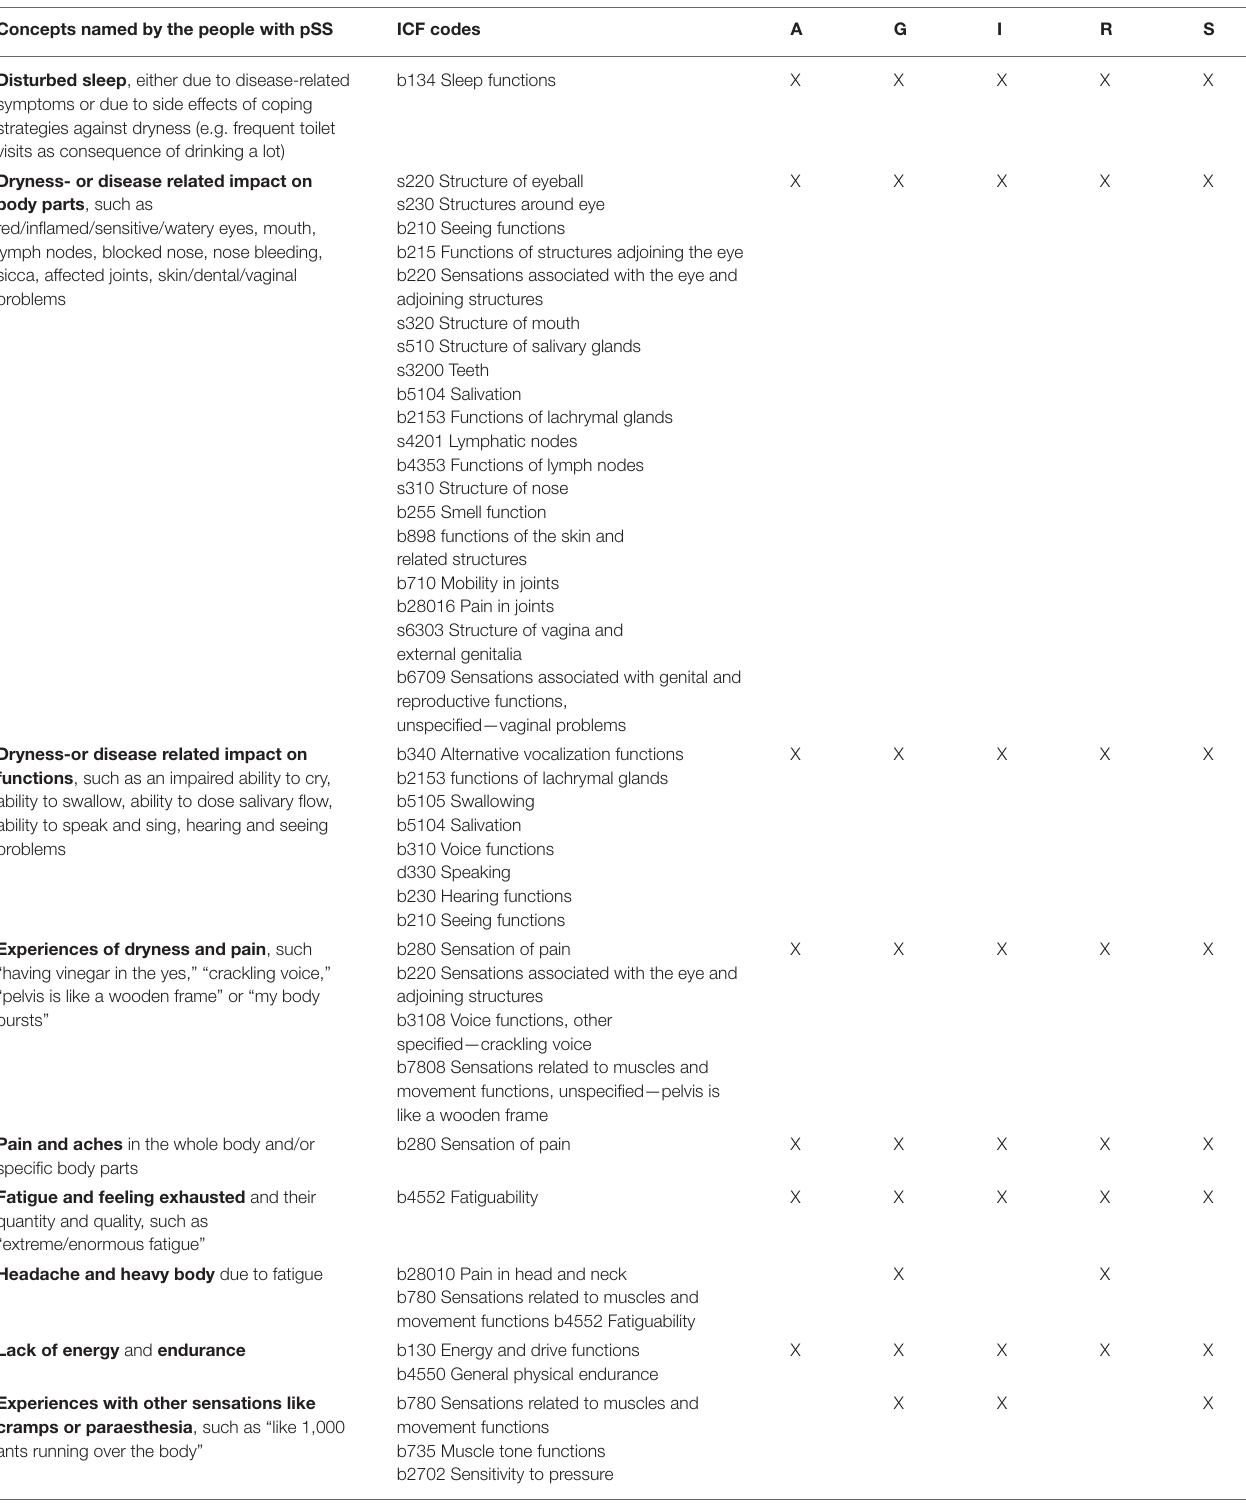
TABLE 4 | Body functions and structures. Concepts named by the people with pSS ICF codes A Disturbed sleep , either due to disease-related symptoms or due to side effects of coping strategies against dryness (e.g. frequent toilet visits as consequence of drinking a lot) Dryness- or disease related impact on body parts , such as red/inflamed/sensitive/watery eyes, mouth, lymph nodes, blocked nose, nose bleeding, sicca, affected joints, skin/dental/vaginal